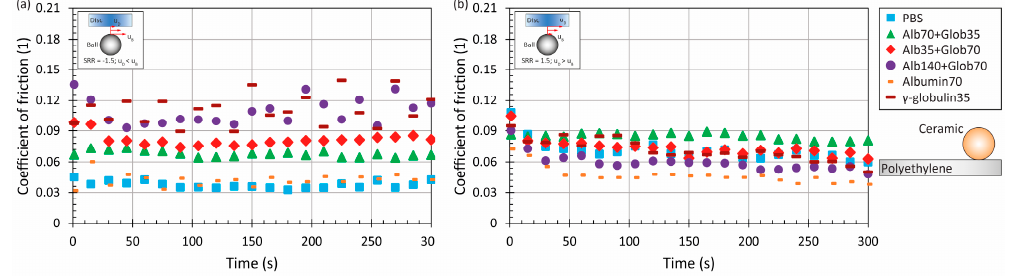
Figure 9. Development of CoF as a function of time for ceramic-on-polyethylene pair at higher mean speed under negative ( a ) and positive ( b ) sliding conditions for various model fluids.